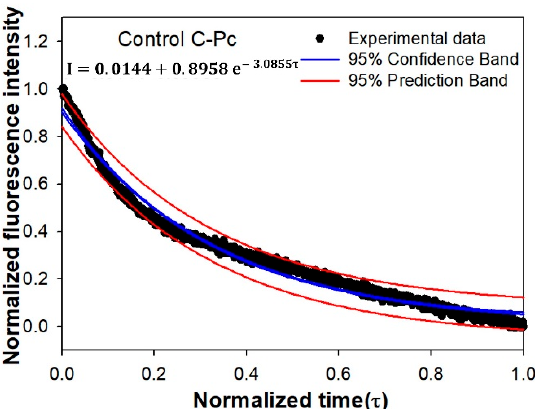
Figure 6. Mathematical modeling of normalized fluorescence decay. Normalized fluorescence intensities were excited at 609 nm and emitted at 643 nm for 1000 times (100 ms/measure). Another differential model was suggested to represent both the exponentially de- creasing (early period) and linearly decreasing (later period) pattern of fluorescence (Equation (6)), and its algebraic model was also formulated (Equation (7)).